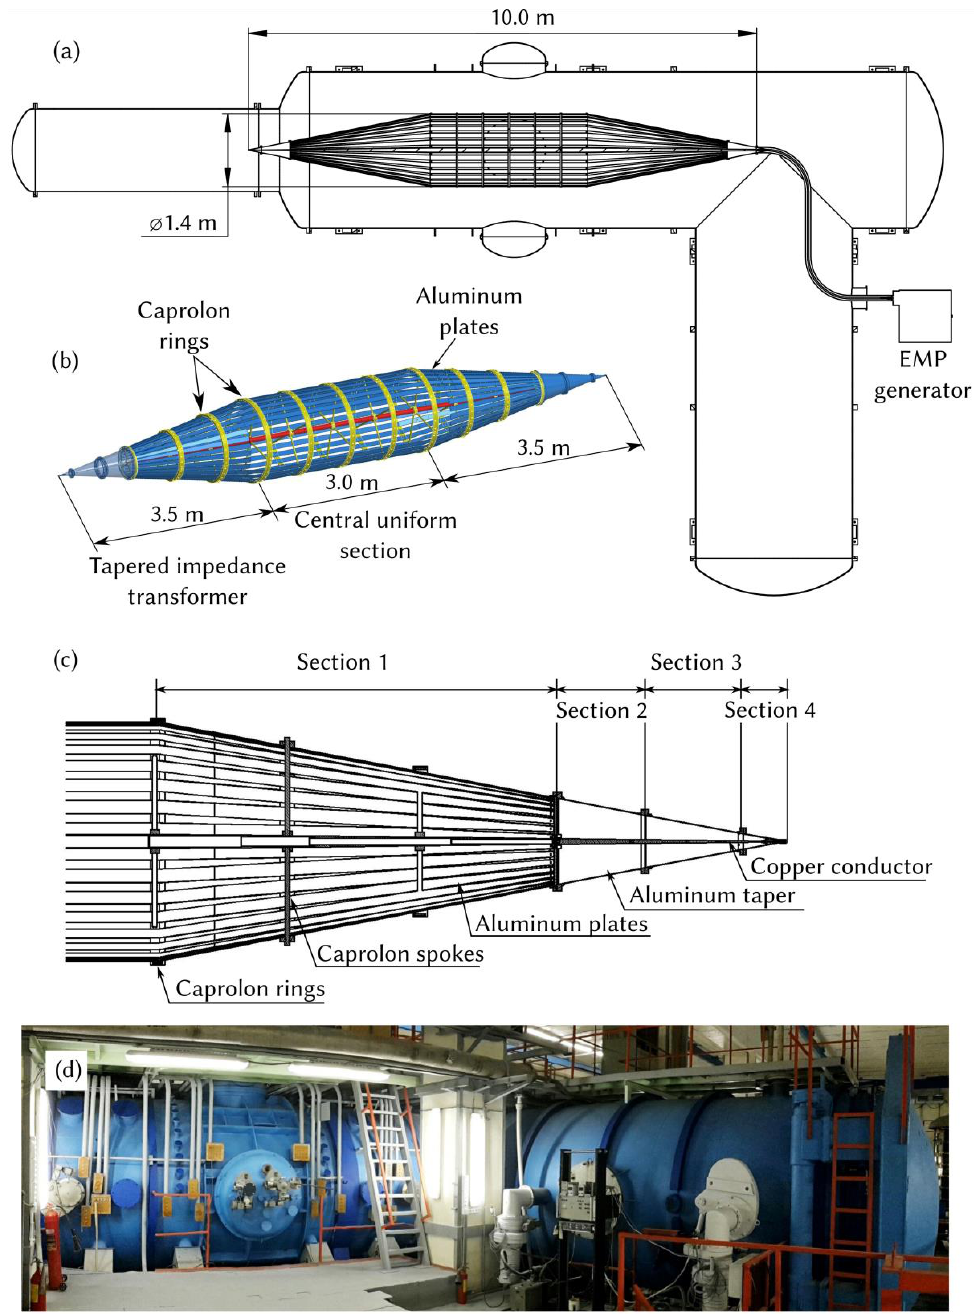
Figure 1. ( a ) General layout of KROT plasma chamber with coaxial line installed inside it; ( b ) 3D model of the “gigantic” coaxial line; ( c ) detailed layout of tapered transition; and ( d ) photograph of the plasma chamber.